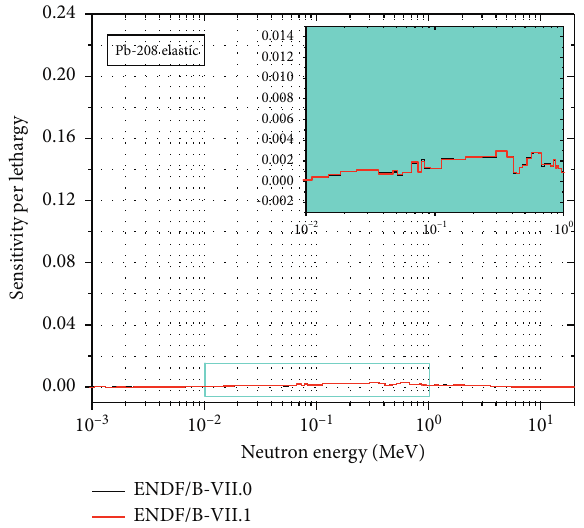
Figure 13: Energy-dependent sensitivities of k to 56 Fe elastic eff scattering cross section.